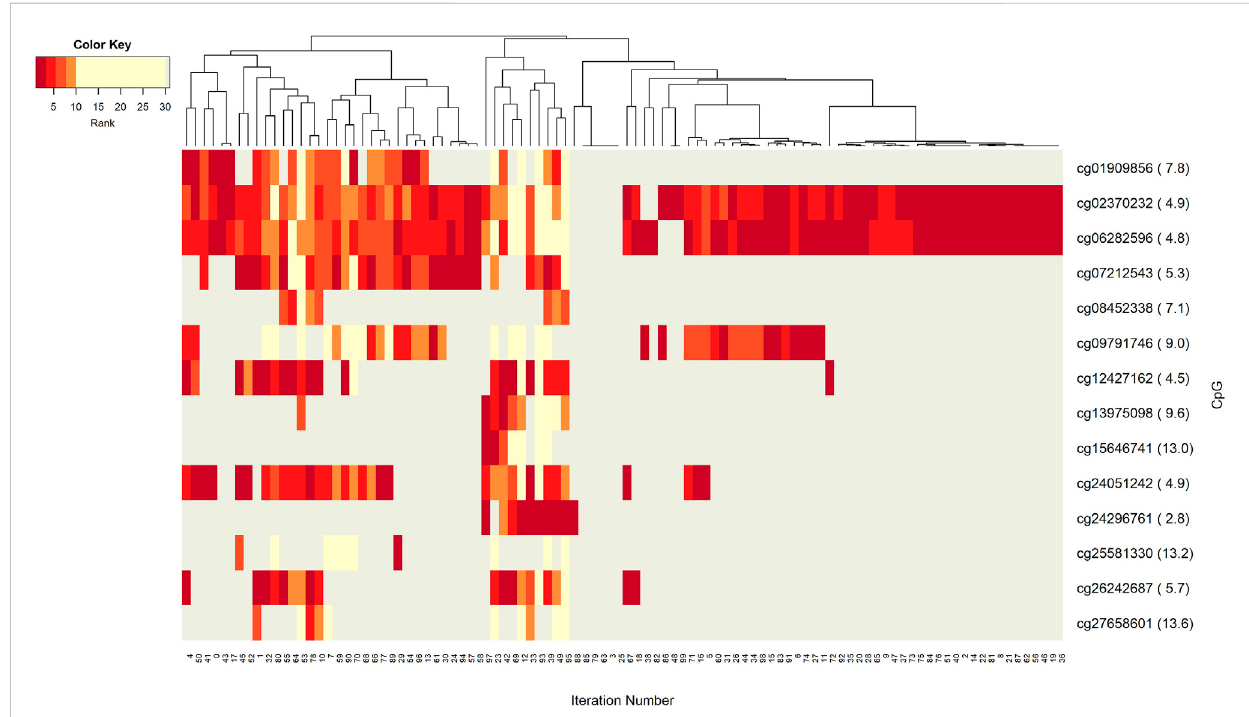
FIGURE 5 Heatmap of CpG features with rank information for each split. Heatmap illustrates co-occurrence patterns of the group component CpGs over